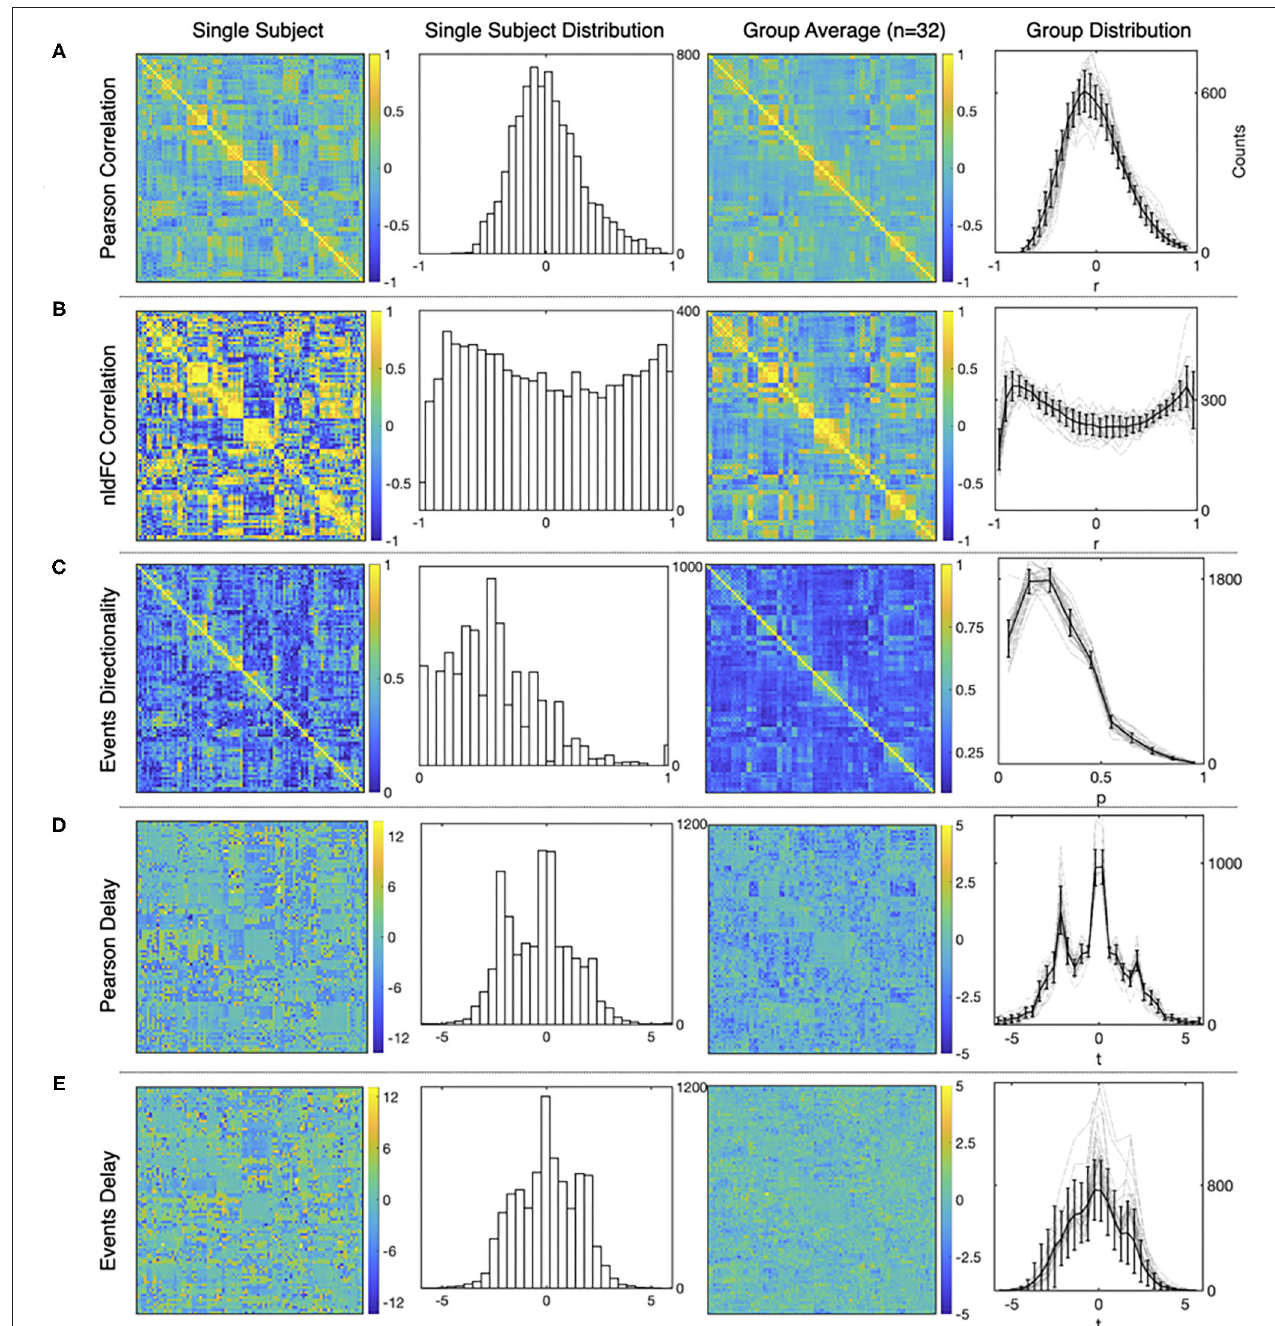
FIGURE 4 | Examples of the matrices and distributions for each calculation performed over a fMRI dataset of 90 time series from the AAL atlas Tzourio-Mazoyer et al. (2002). The first and the second columns corresponds to a single subject statistics, while the average results from a group of healthy subjects ( n = 32) are shown in the third and the fourth column. (A–E) show results for Pearson functional correlations, event correlations, event asymmetry, Pearson’s delay, and event delay, respectively. For each measure, the first and the third columns show results in a matrix format, while the second and the fourth columns show the distributions of each measure (mean values and S.D. error bars are used for the group distributions).